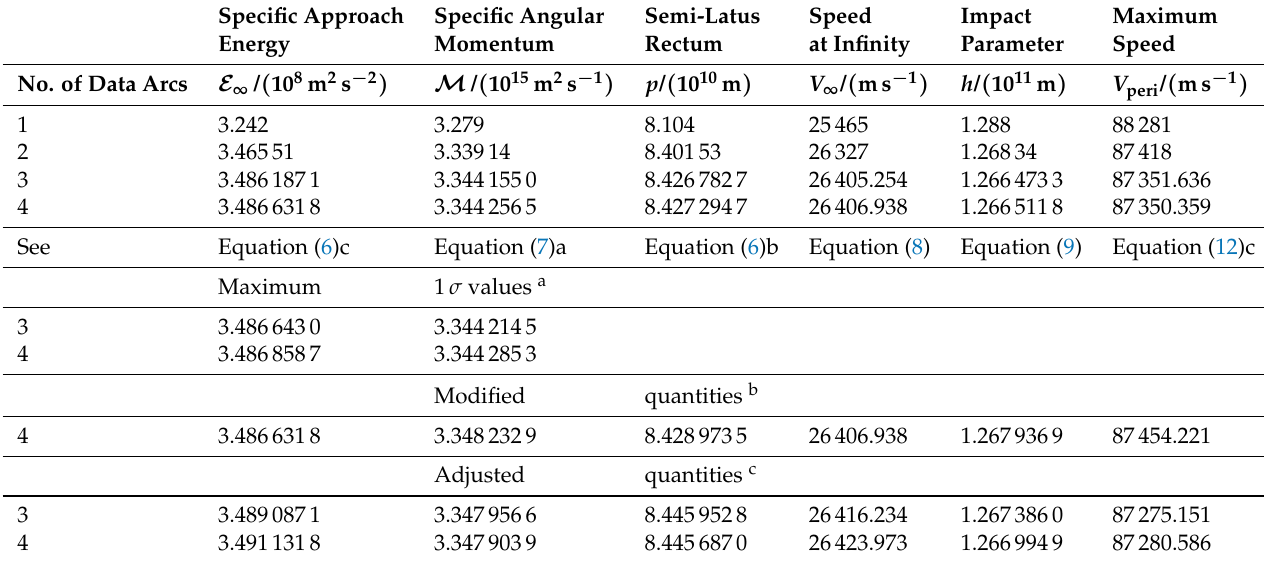
Table 2. Additional orbit characteristics derived from the eccentricities and perihelion distances of the data arcs No. 1 to 4 as well as for modified orbit No. 4 and adjusted orbits No. 3 and 4 in Table